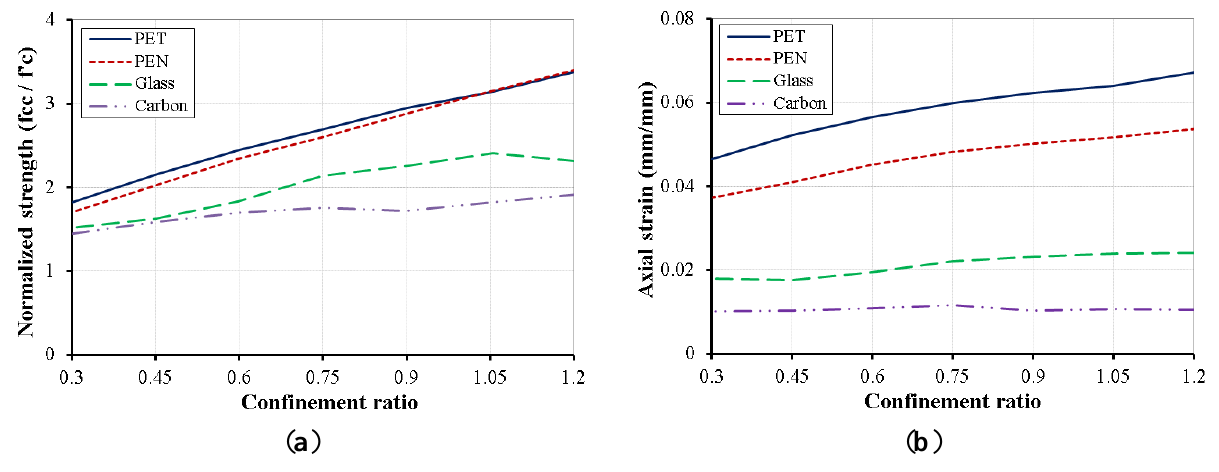
Figure 4. Axial strain-normalized strength ( 𝑓 Carbon FRP with same confinement ratio of 0.9.